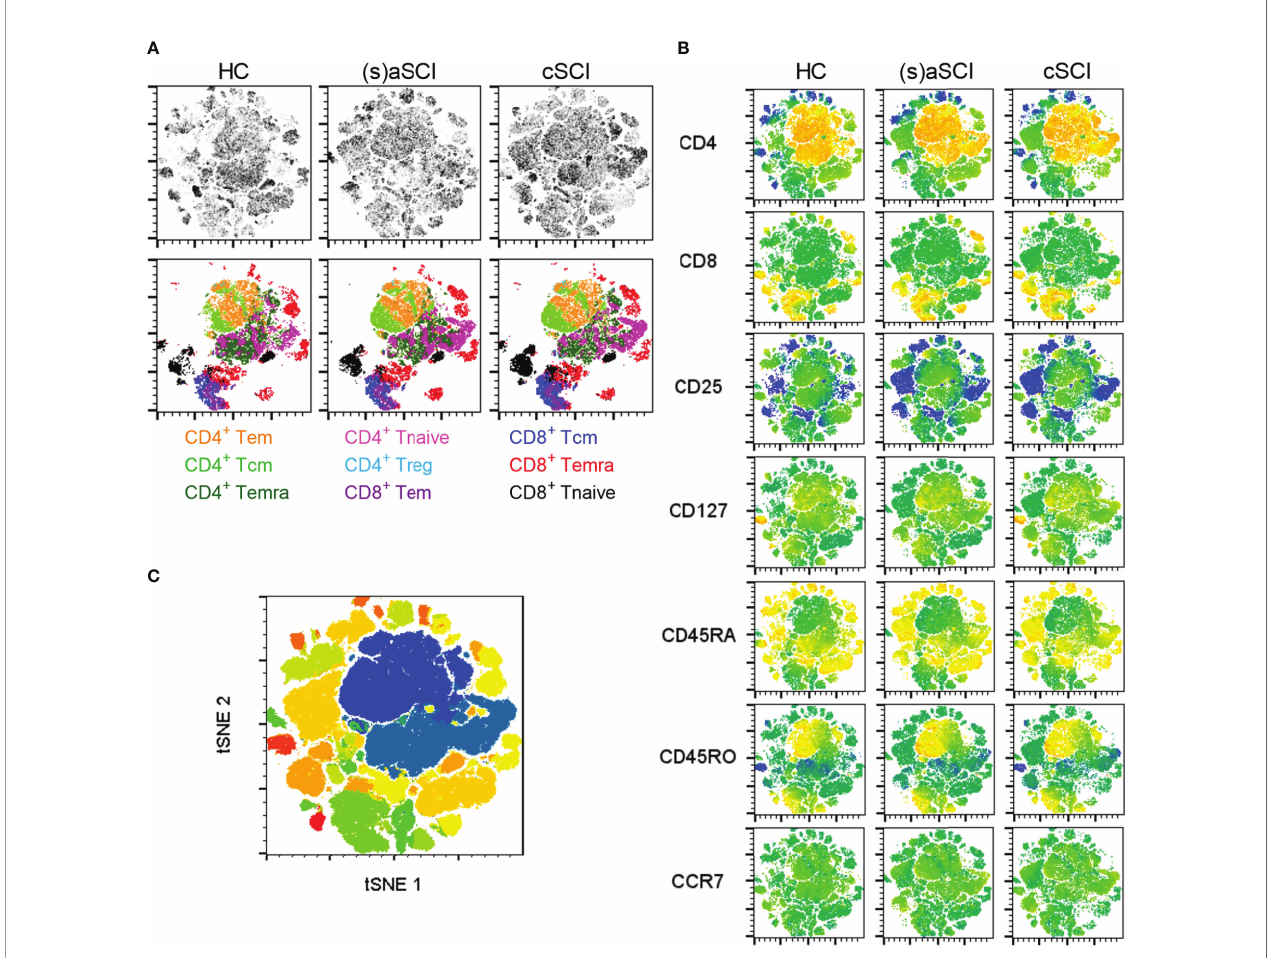
FIGURE 2 | High-dimensional fl ow cytometry of T cell subsets in the peripheral blood of HC and SCI patients. (A) tSNE maps showing T cell subsets within the lymphocyte population of HC (n = 18) and SCI patients (n = 18), including (s)aSCI (16 samples) and cSCI (28 samples). In the upper row, tSNE maps are shown on a density plot while the lower row shows the manually determined gates on the tSNE maps. (B) Surface marker distribution is depicted in the tSNE map. Relative antigen expression is visualized by the color tone (from blue to red). (C) FlowSOM clusters are shown in the tSNE map as overlay. FlowSOM analysis was performed on the lymphocyte population as no general T cell marker was included in the fl ow cytometry